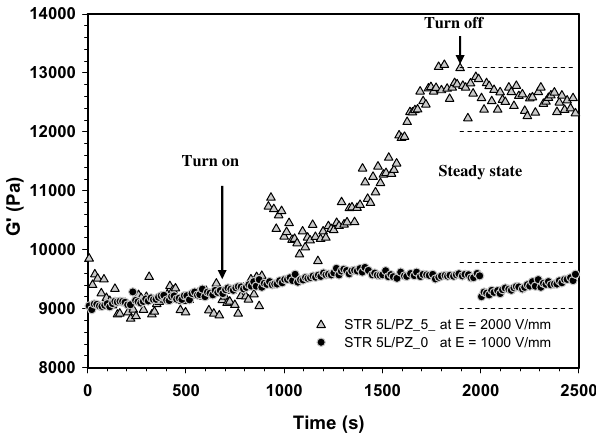
Fig. 6. Temporal response of the storage modulus of NR-STR 5L/PZ 0 and NR-STR 5L/PZ 5 composites at electrical ¯eld strength of 1.0 and 2.0 kV/mm, frequency 1.0 rad/s, strain 0.1%, and at 27 (cid:2)